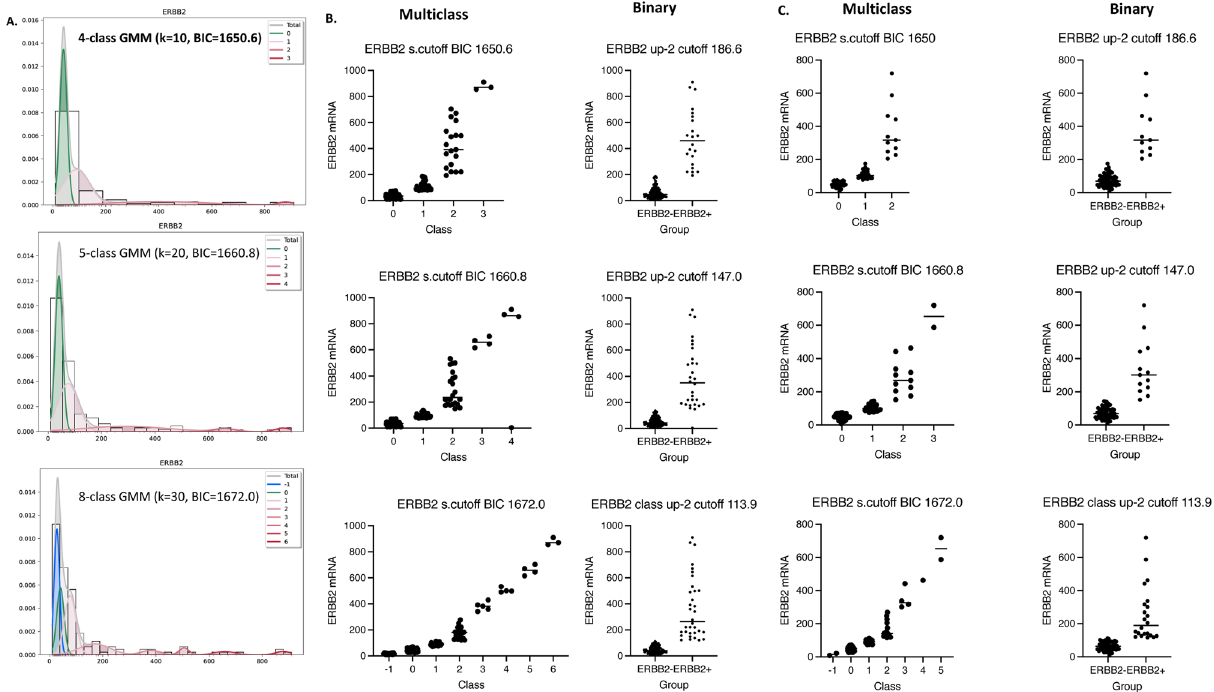
Figure 3. The g3mclass -assisted autoclassification on ERBB2 mRNA. ( A ) A total mixture model and GMM’s components for the test ERBB2 mRNA was obtained with the g3mclass . The data distribution is shown as a PDF overlaid on a histogram and estimated by the means values, standard deviation, and weights of each component. The total GMM (gray); separate components are as follows: green—class 0 with the mean value of reference; class/es with the mean value lower than that of reference (blue) and class/es with the mean value higher than that of reference (red). The ERBB2 mRNA model parameters including the mean ± standard deviation values and weights per class are: 4-class GMM: class 0 (40.4 ± 13.6; weight 0.46); class 1 (88.7 ± 48.9, weight 0.38), class 2 (403 ± 189, weight 0.14), class 3 (879 ± 29.1, weight 0.02); 5-class GMM: class 0 (40.4 ± 13.6; weight 0.43), class 1 (74.8 ± 37.9; weight 0.36), class 2 (287 ± 155; weight 0.17), class 3 (661 ± 38.7; weight 0.03), class 4 (878 ± 28.6; weight 0.02); 8-class GMM: class − 1 (27.0 ± 10.1; weight 0.21), class 0 (40.4 ± 13.6; weight 0.20), class 1 (77.2 ± 21.8; weight 0.28), class 2 (168 ± 57.6; weight 0.14), class 3 (381.0 ± 36.0; weight 0.04), class 4 (506 ± 18.6; weight 0.03); class 5 (659 ± 38.1; weight 0.03); class 6 (878 ± 28.6; weight 0.02). The best fit was obtained for the 4-class GMM based on the lowest BIC = 1650.6. ( B ) Graphs: Examples of the multiclass and subsequent binary classifications of IBC on ERBB2 mRNA . ( C ) Graphs: Examples of multiclass and subsequent binary classification of DCIS on ERBB2